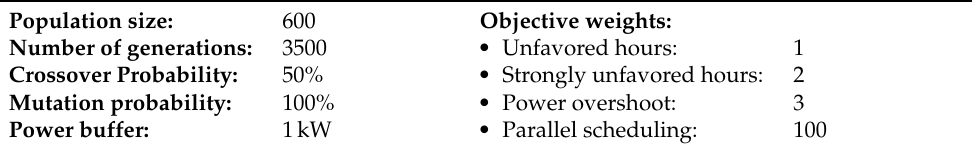
Table 8. Parameter values chosen for the genetic algorithm.